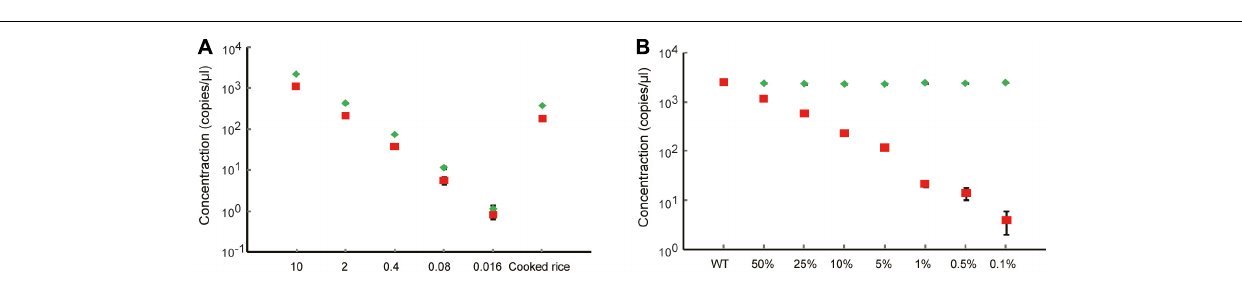
FIGURE 3 | Ultra-sensitive detection of gene-edited samples. (A) Detection of heterozygous gene-edited samples containing different initial concentrations of DNA and cooked rice by dPCR. The red square and the green diamond show the concentrations of mutant droplets and wild-type droplets, respectively. All data are show as the mean ± standard deviation (SD) of three replicates. (B) Accurate quantification of the gene-editing induced mutation ratio in mixed samples. The red square and the green diamond show the concentrations of mutant droplets and wild-type droplets, respectively. All data are show as the mean ± standard deviation (SD) of three